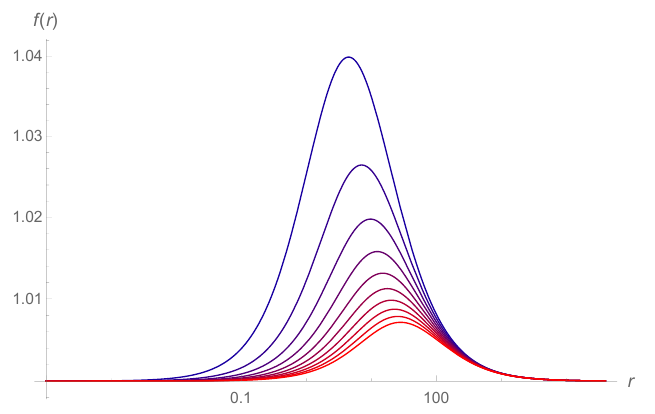
Figure 10 . Log-log plot of the numerical solution for f for A = 1 (blue) to A = 10 (red).